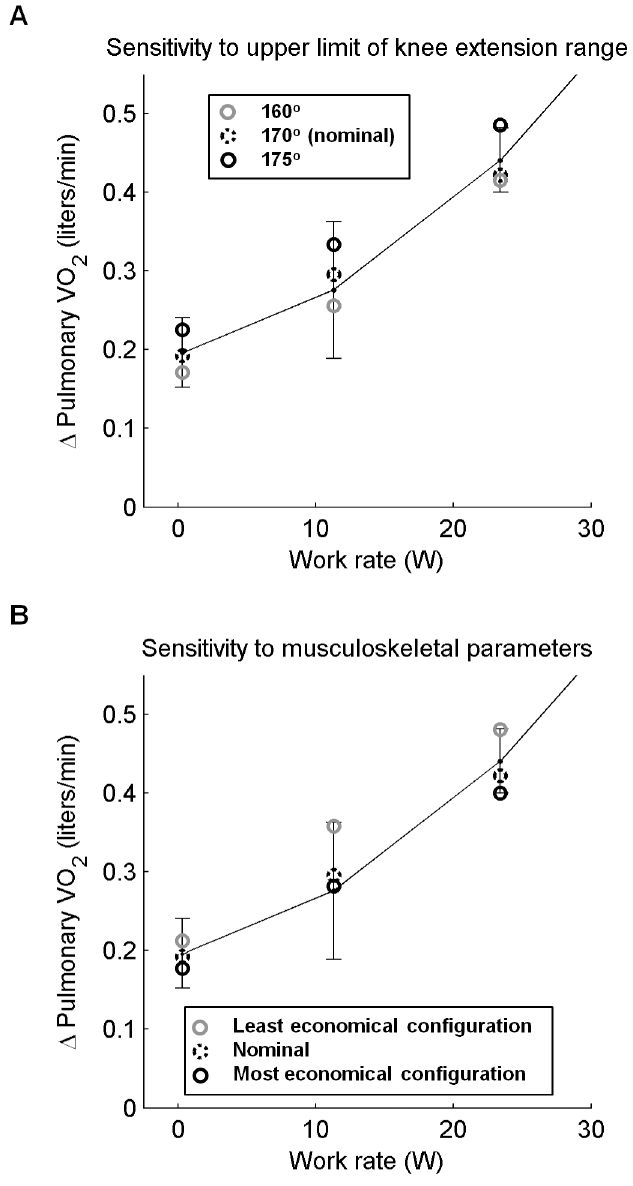
Fig 6. Sensitivity analysis. A. Effect of upper limit of knee extension range on pulmonary VO 2 predictions. B. Energetic predictions using nominal, least and most economical musculoskeletal configurations. Mean experimental VO 2 plus/minus one standard deviation is plotted for